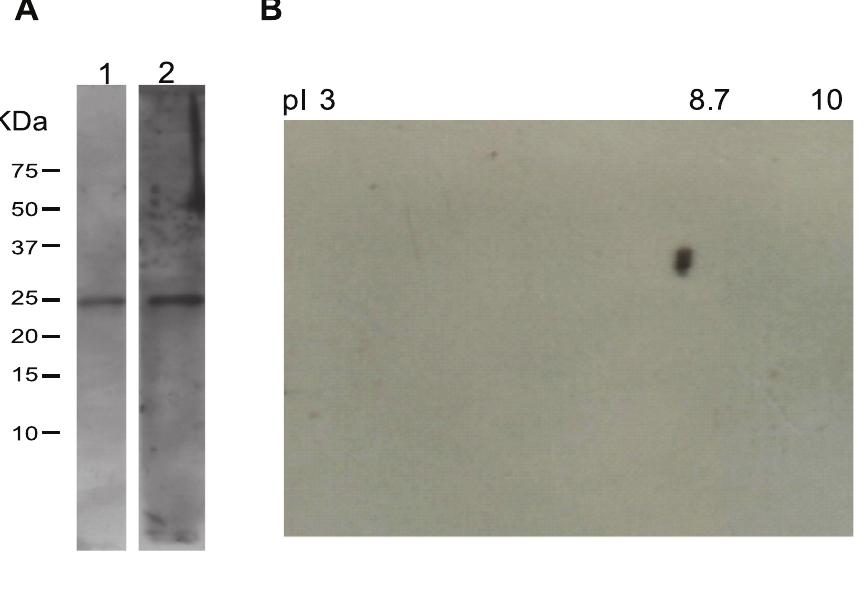
Figure 2. Immunodetection of Rab11 in Giardialamblia lysates. ( A ). Immunoblot analysis of extracts from Giardia trophozoites and cysts. 30 m g of each extracts were separated on 12% SDS-PAGE transferred to a nitrocellulose membranes and probed with anti-Rab11 policlonal antibody. The antibody detects a single band with a molecular weight near 24 kDa. Lanes 1 and 2 correspond to trophozoites and cysts, respectively. ( B ). Two- dimensional electrophoresis (only one spot, pI of 8.7, was identified).